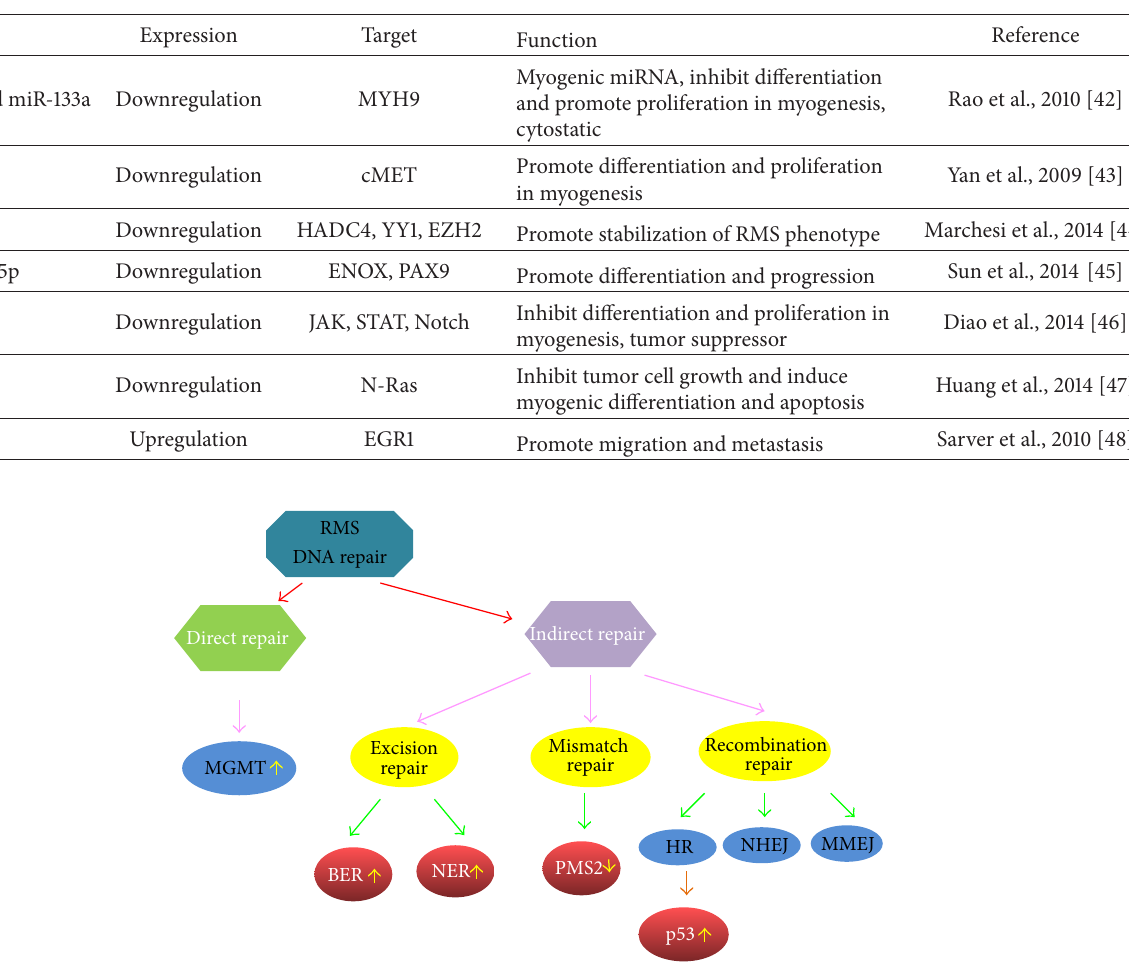
Figure 4: The DNA repair systems in RMS. There are two pathways repairing the DNA lesions, directly without affecting DNA structure and indirectly by DNA phosphodiester backbone cleavage. The modifications in DNA repair enzymes expression or activity lead to resistance to chemotherapy and radiation in RMS tumor cells. MGMT, O 6 -methylguanine-DNA methyltransferase; BER, base excision repair; NER, nucleotide excision repair; HR, homologous recombination; NHEJ, nonhomologous end-joining; MMEJ, microhomology-mediated end-